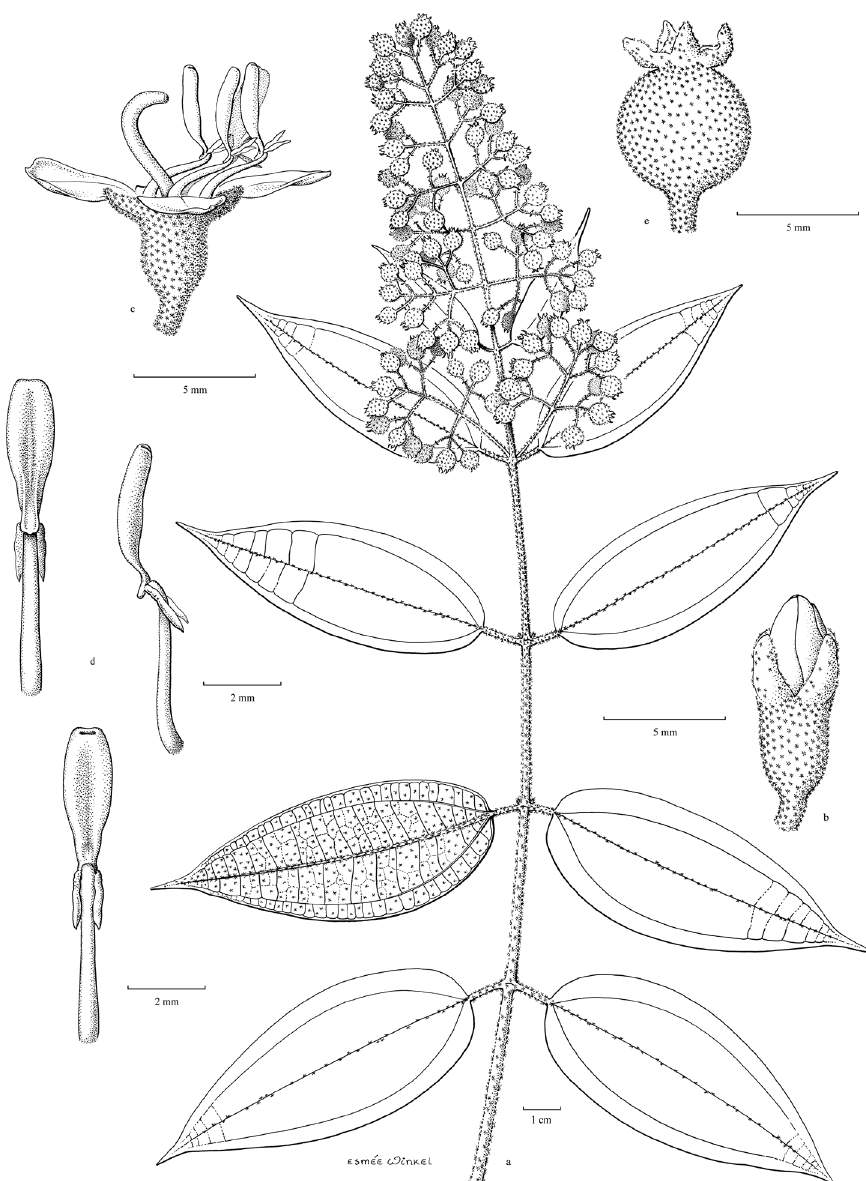
Figure 10. Dissochaeta celebica var. longilobata a habit b hypanthium c open flower d stamens e fruit. [drawn from Van Balgooy 3205